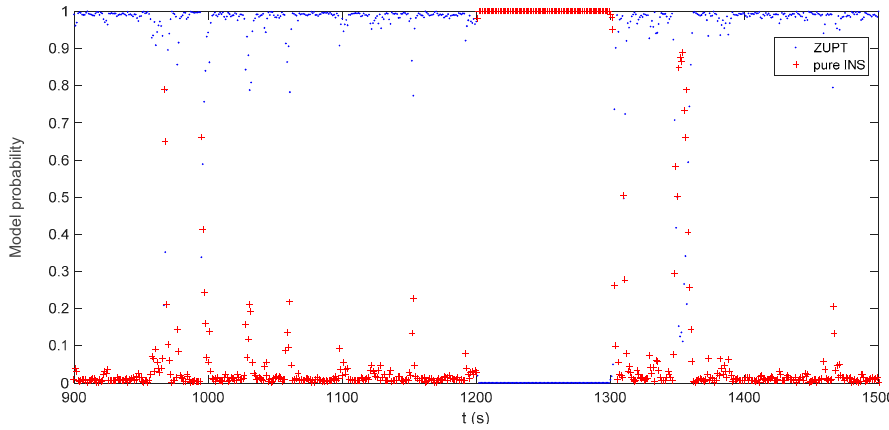
Figure 19. Model probability of the IMM-aided ZUPT solution during DVL outage.